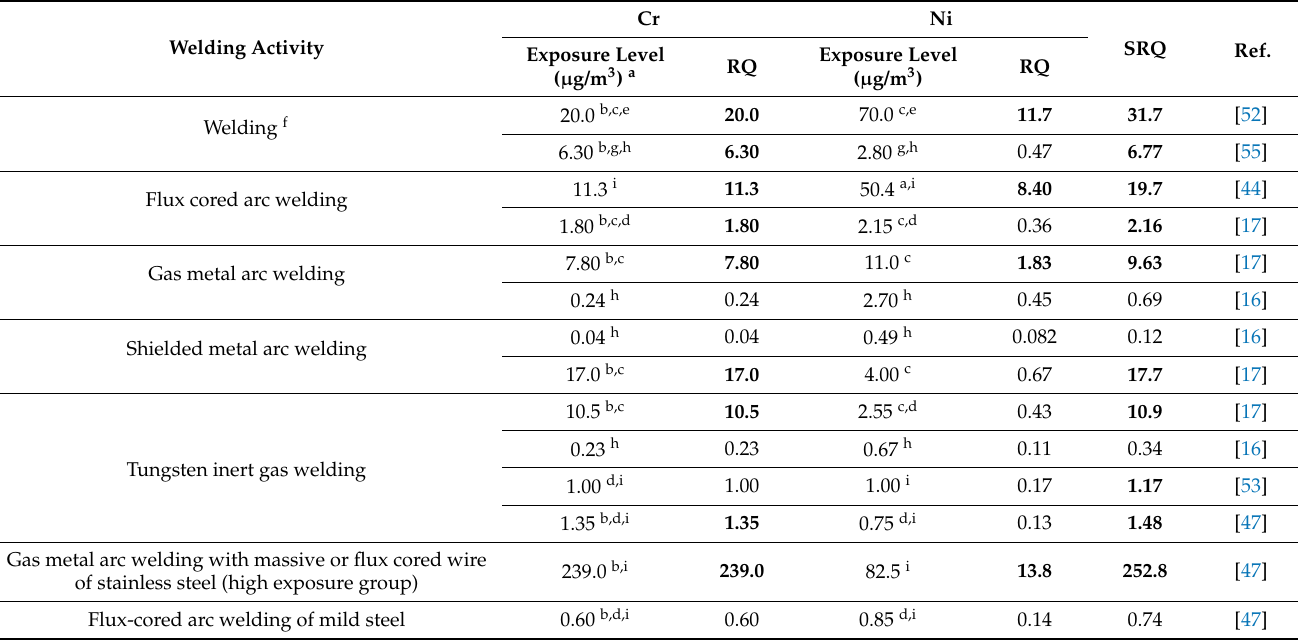
Table 3. External exposure levels of Cr and Ni (air measurements) of workers performing welding activities, and values obtained for RQ and SRQ.